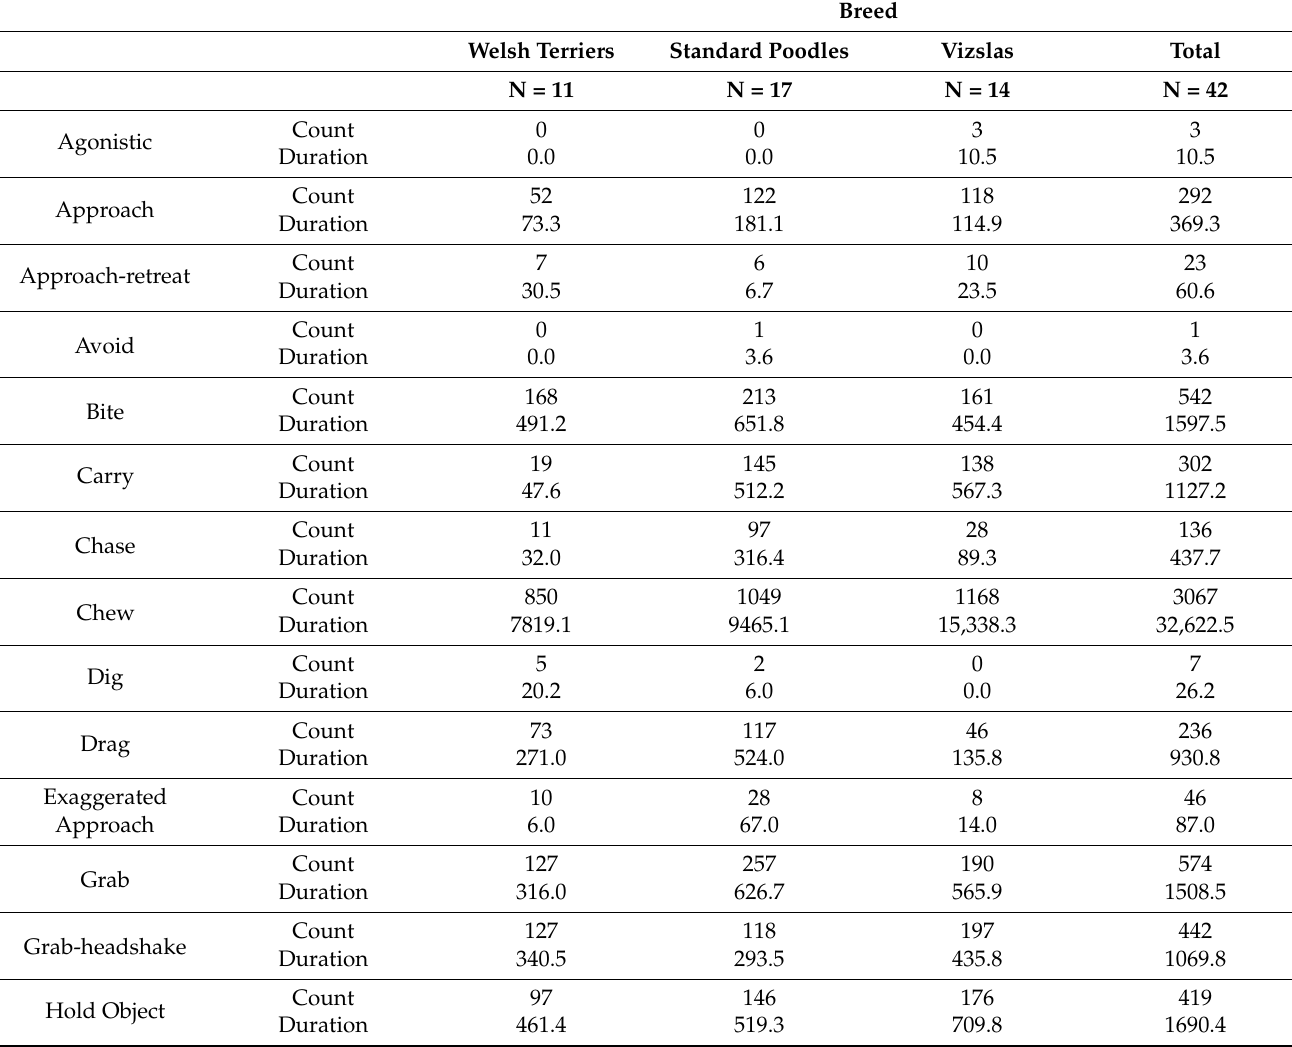
Table 3. Total Frequency of Individual Behaviors. Total counts and durations (in seconds) are listed for each behavior by breed collapsed across total observation periods (3–7 weeks).